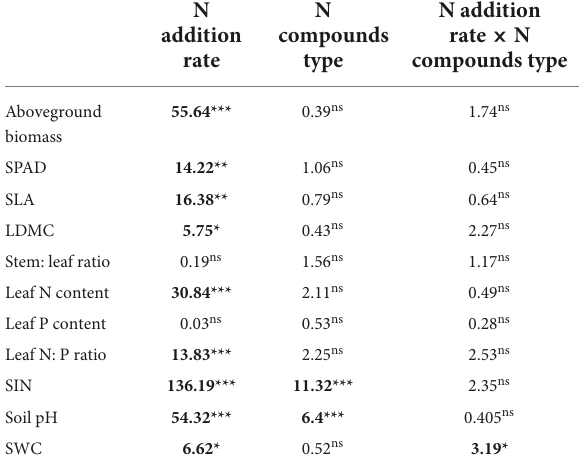
stem: leaf ratio, leaf N concentration, leaf P concentration, leaf N: P ratio of Leymus chinensis , and soil inorganic nitrogen content (SIN), soil pH, soil water content